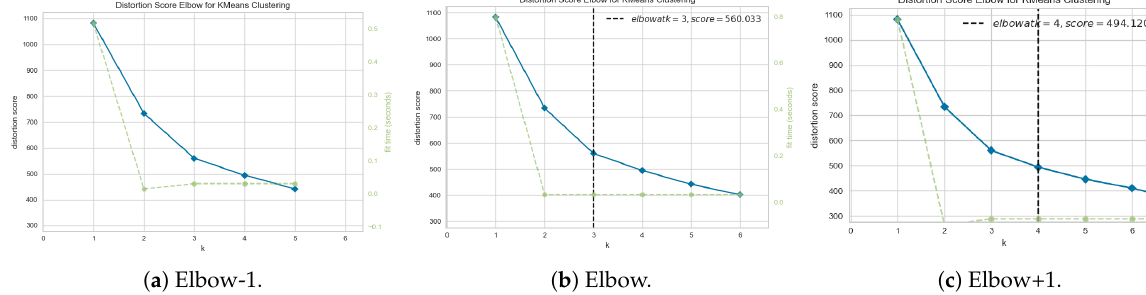
Figure 4. Elbow method applied.